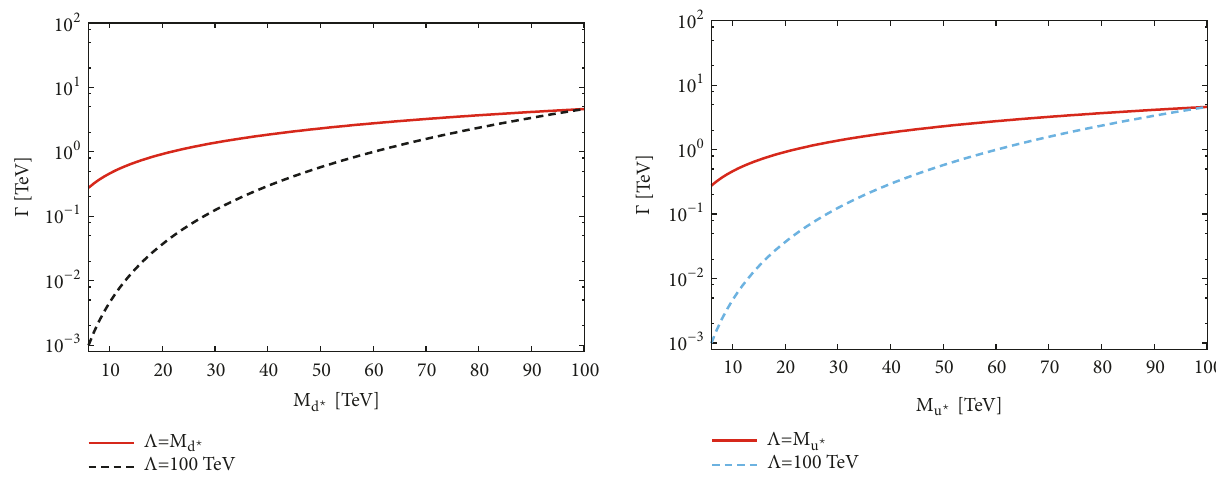
Figure 1: Decay widths versus first generation excited quark masses for both Λ = 𝑀 𝑑 ⋆ , Λ = 𝑀 𝑢 ⋆ , and Λ = 100 TeV.